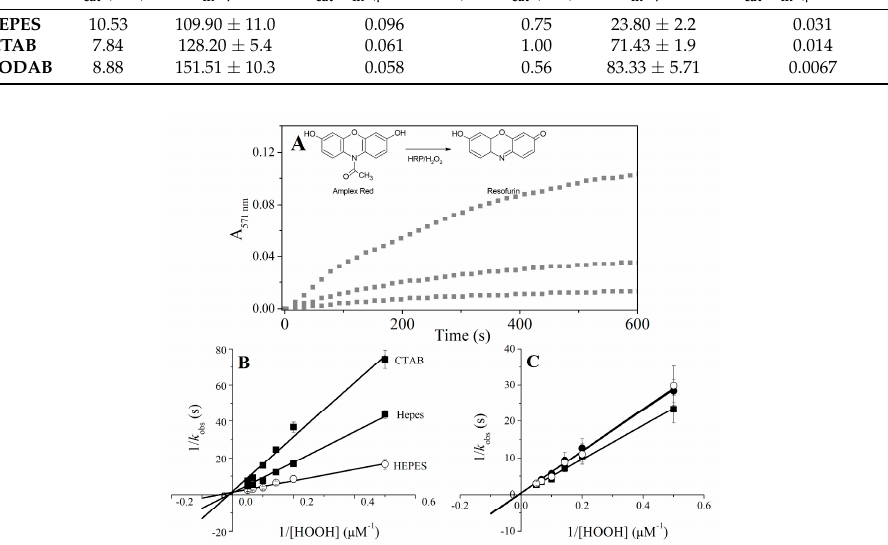
Table 3. Kinect Parameters for Reaction of H 2 O 2 with HRP and Fe(III)MP-11.